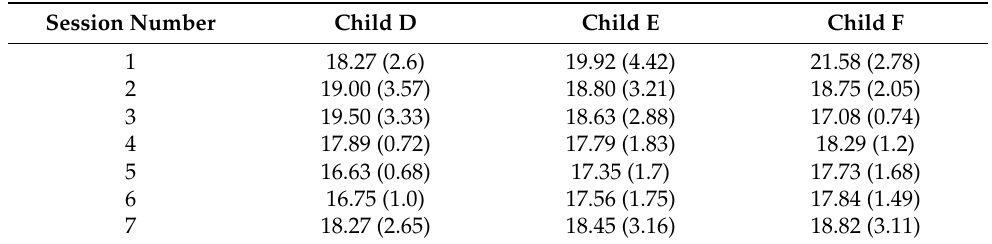
Table 10. Subset two: Children’s mean response time in seconds for successful answers (SD) in the EMOTIONS activity. In general, the response time increased in the last session. Session